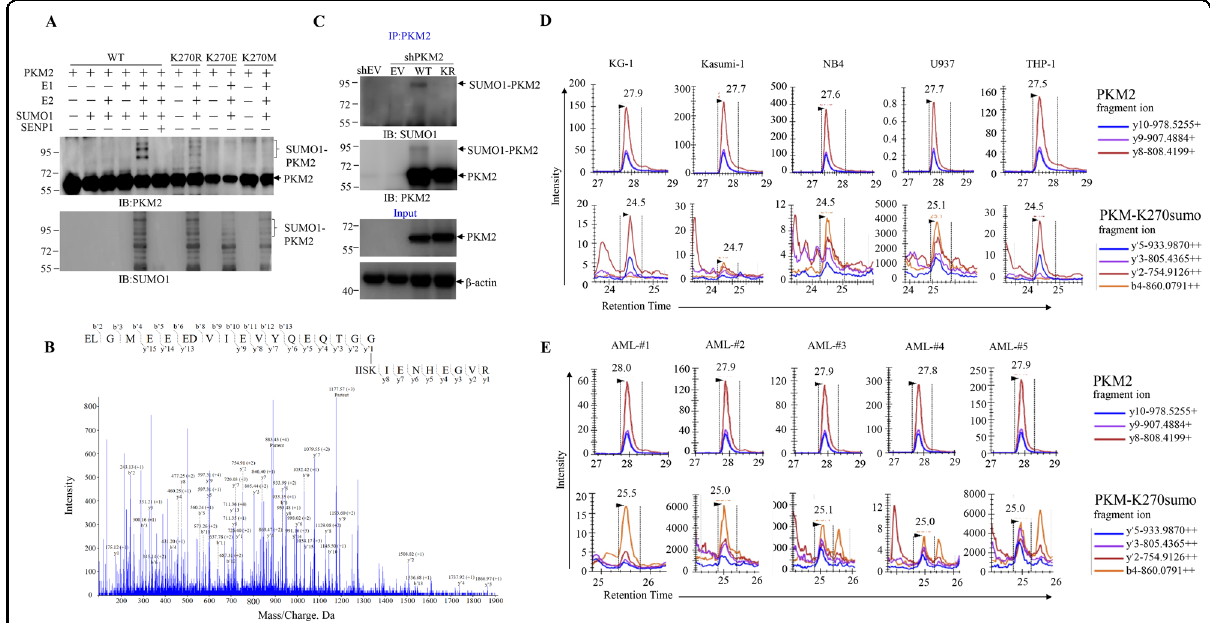
Fig. 2 K270 is the major SUMOylation site in PKM2. A In vitro SUMOylation of PKM2. Recombinant wild type (WT) or K270R mutant His-tagged PKM2 were incubated with recombinant SUMO1 in the presence of puri fi ed E1(SAE1/UBA2) and E2(UBC9) with or without SENP1. SUMO1 modi fi cation were detected using antibody against PKM2 or SUMO1. K, lysine; R, arinine; E, glutamic acid; M, methionine. B SUMOylated PKM2 peptide identi fi ed by MS. Recombinant PKM2 protein was digested by trypsin and subjected to LC-MS/MS for identi fi cation. The lysine conjugated with QTGG remnant indicates the SUMOylation site. C WT or K270R mutant (KR) Flag-tagged PKM2 were infected into NB4 cells that endogenous PKM2 were depleted. The SUMO1 modi fi cation were measured by IP with anti-PKM2 antibody. D , E Multiple-reaction monitoring mass spectrometry (MRM-MS) analysis of SUMOylated PKM2 in leukemia cell lines ( D ) and primary samples from patients with AML ( E